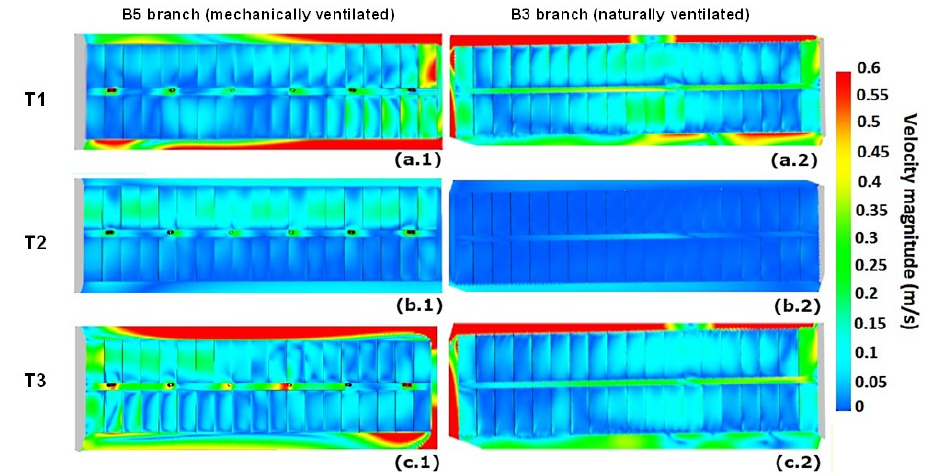
Figure 5. Indoor air velocity distribution 0.5 m above the pavement for different observation days (T), for mechanically ventilated building B5 (( a.1 ) at T1; ( b.1 ) at T2; ( c.1 ) at T3) and naturally ventilated building B3 (( a.2 ) at T1; ( b.2 ) at T2; ( c.2 ) at T3). Further details of the air velocity magnitude are shown in Table 7. Table 7. Indoor mean air velocity magnitude (V) obtained from the CFD simulations at a level of 0.50 m from the pave- ment, for the pens on the left and on the right of the central corridor, for buildings W3 and W5. Time dd/mm/yyyy V mean,left (m/s) V mean,right (m/s)